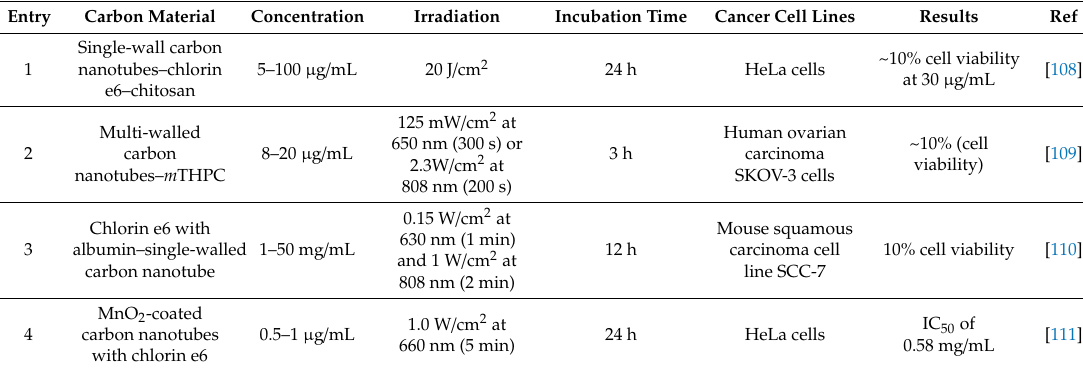
Table 4. Parameters used for chlorin-based photosensitizers immobilized on carbon nanotubes as a photosensitizer against